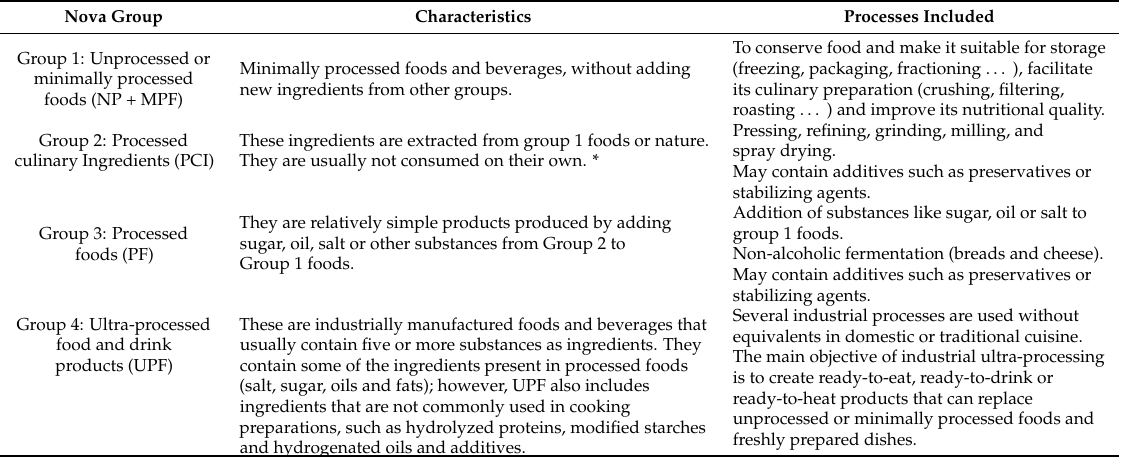
Table 1. Summary of the NOVA classification